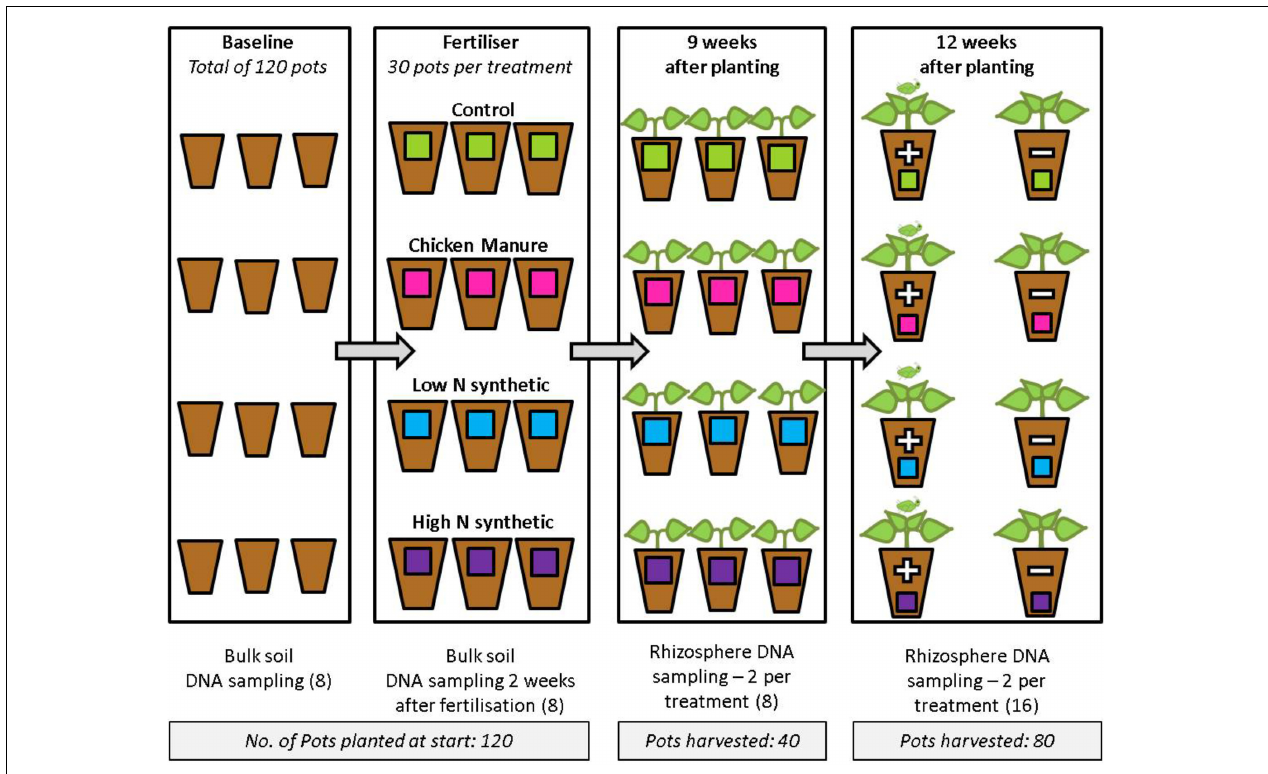
FIGURE 1 | Experimental design showing stages at which DNA sampling was carried out. Each pot represents 10 replicates and each DNA sample was obtained from a pooled sample of soil taken from five pots. Numbers in brackets represent the total number of DNA samples taken at each sampling stage that were subsequently sequenced on the Illumina MiSeq. At the final (12 weeks) sampling stage, the “+” indicates plants infested with aphids, and “–” indicates non-infested